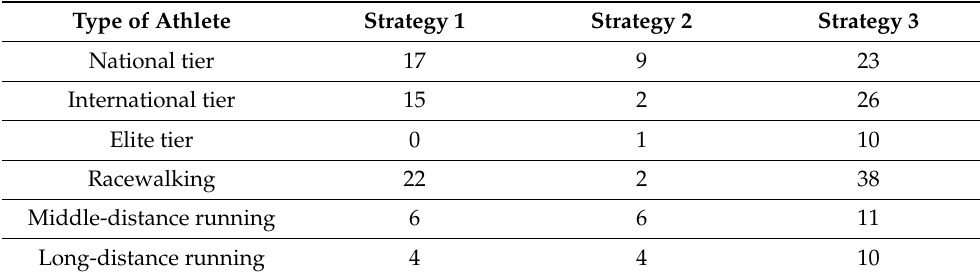
Table 9. The number of athletes using different recovery